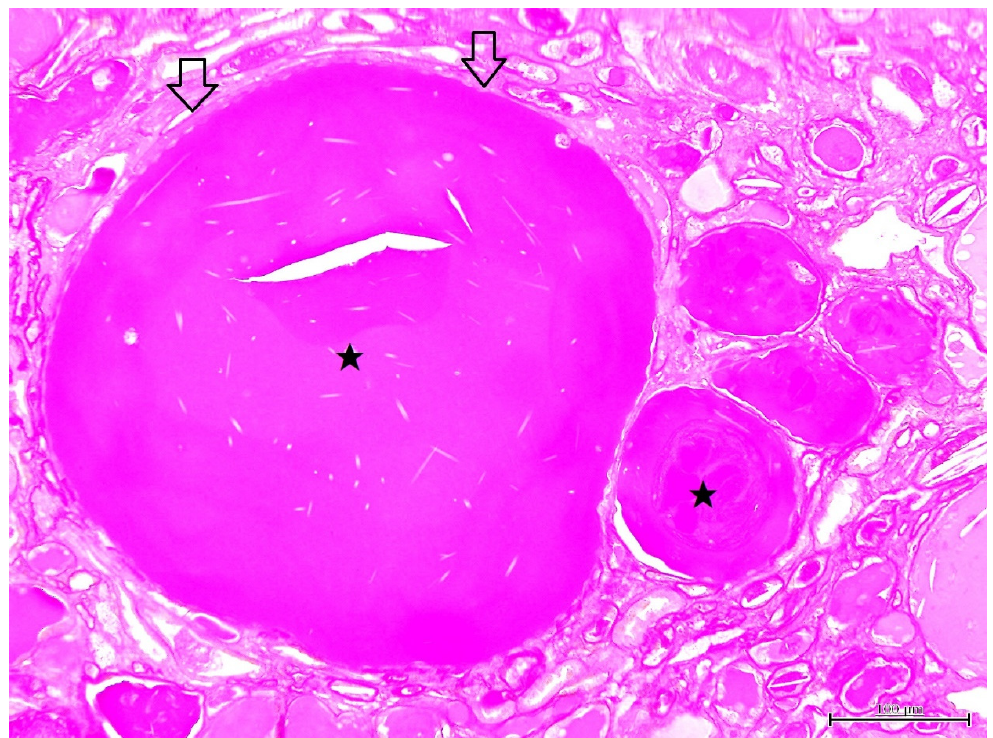
Figure 4. Microscopic finding of polycystic kidney. The cyst contains mucopolysaccharides or mucoproteins (solid star). The cysts are lined by a flattened single epithelium (open arrow). PAS stain. × 200, Bar = 100 µ